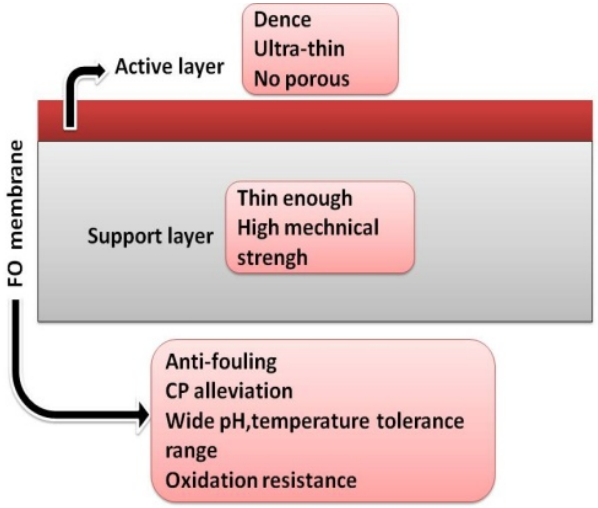
Figure 1. The ideal TFC-FO membrane model.